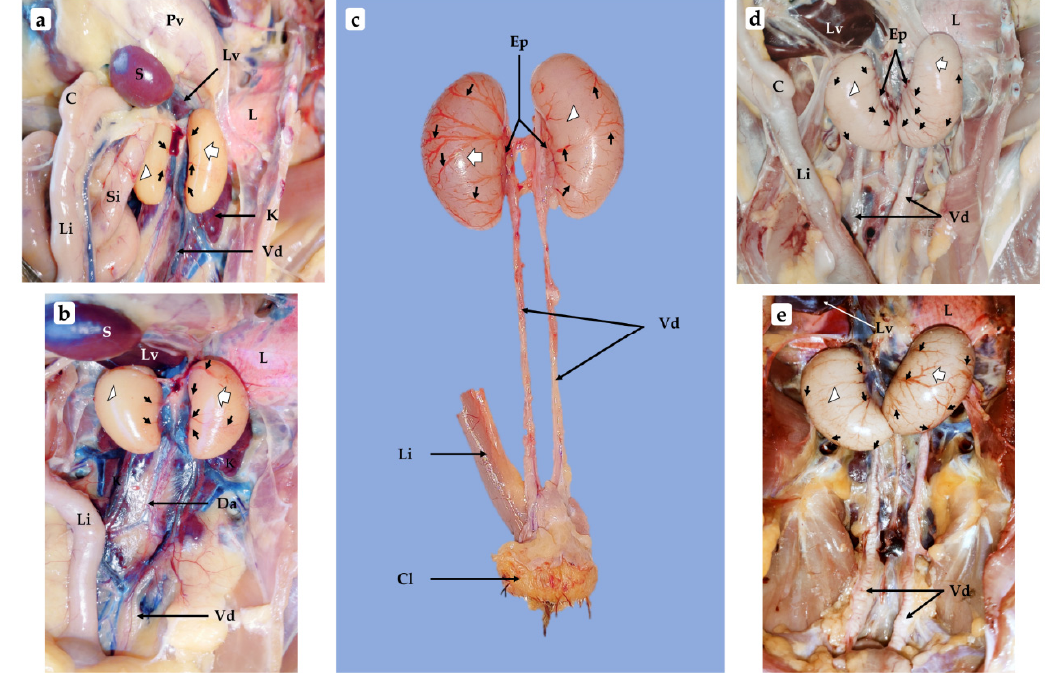
Figure 3. Morphological photographs of chicken testes during growth from 2-mo-old to 4-mo-old: ( a , b ) 2-mo-old; ( c ) 3-mo-old; ( d , e ) 4-mo-old. Proventriculus (Pv), interior portion of the liver (Lv), spleen (S), caecum (C), large intestine (Li), small intestine (Si), caudal end of the left lung (L), left testis (white arrow), right testis (white arrowhead), vascularization growing on the testes surface (black arrows), left kidney (K), vas deferens (Vd), dorsal aorta (Da), epididymis (Ep), cloaca (Cl).